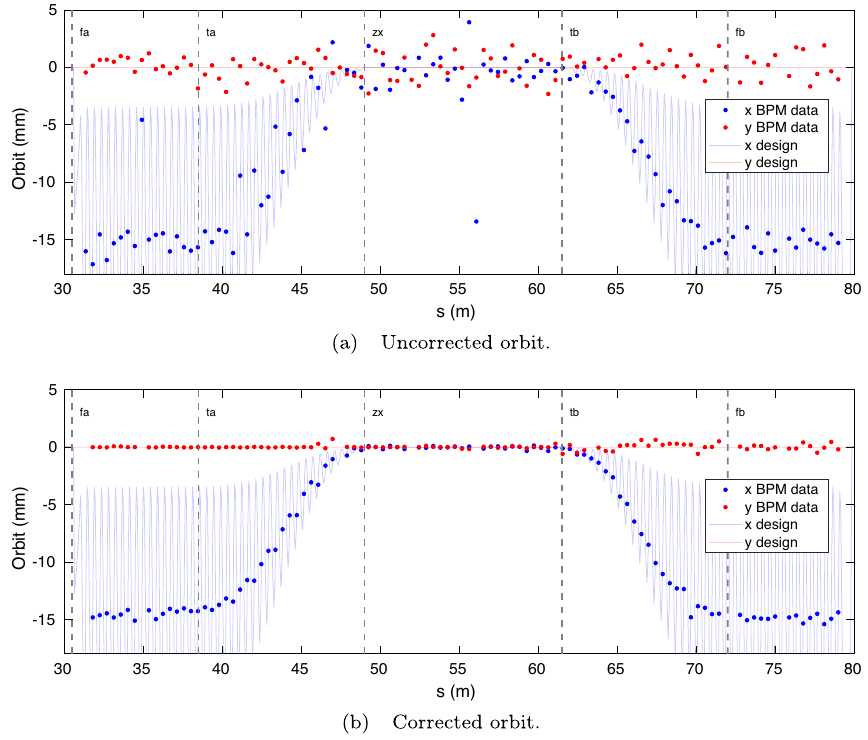
FIG. 3. Online 1-pass orbit correction using SVD: (a) an example initial orbit tuned by hand (b) an orbit tuned using the SVD algorithm. The solid blue and red lines indicate the design orbit in the online